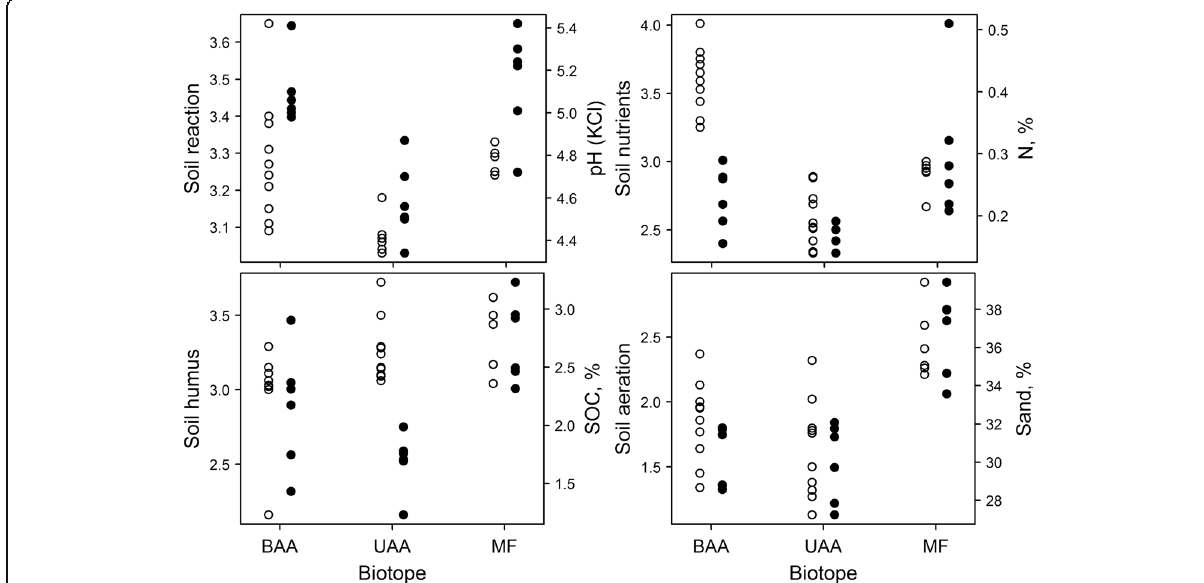
Fig. 10 Measured soil characteristics (black dots) and Landolt ’ s scores calculated by species indicator values (white dots) for the plots in the studied biotopes: BAA and UAA burnt and unburnt abandoned arable land, and MF mature